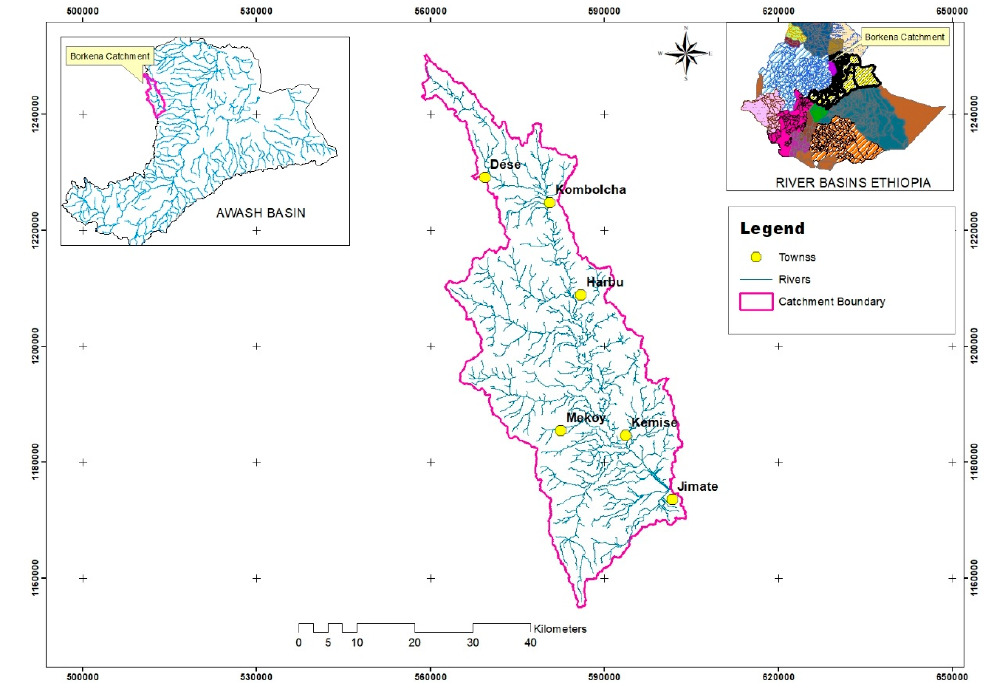
Figure 1. Location map of Borkena Catchment.